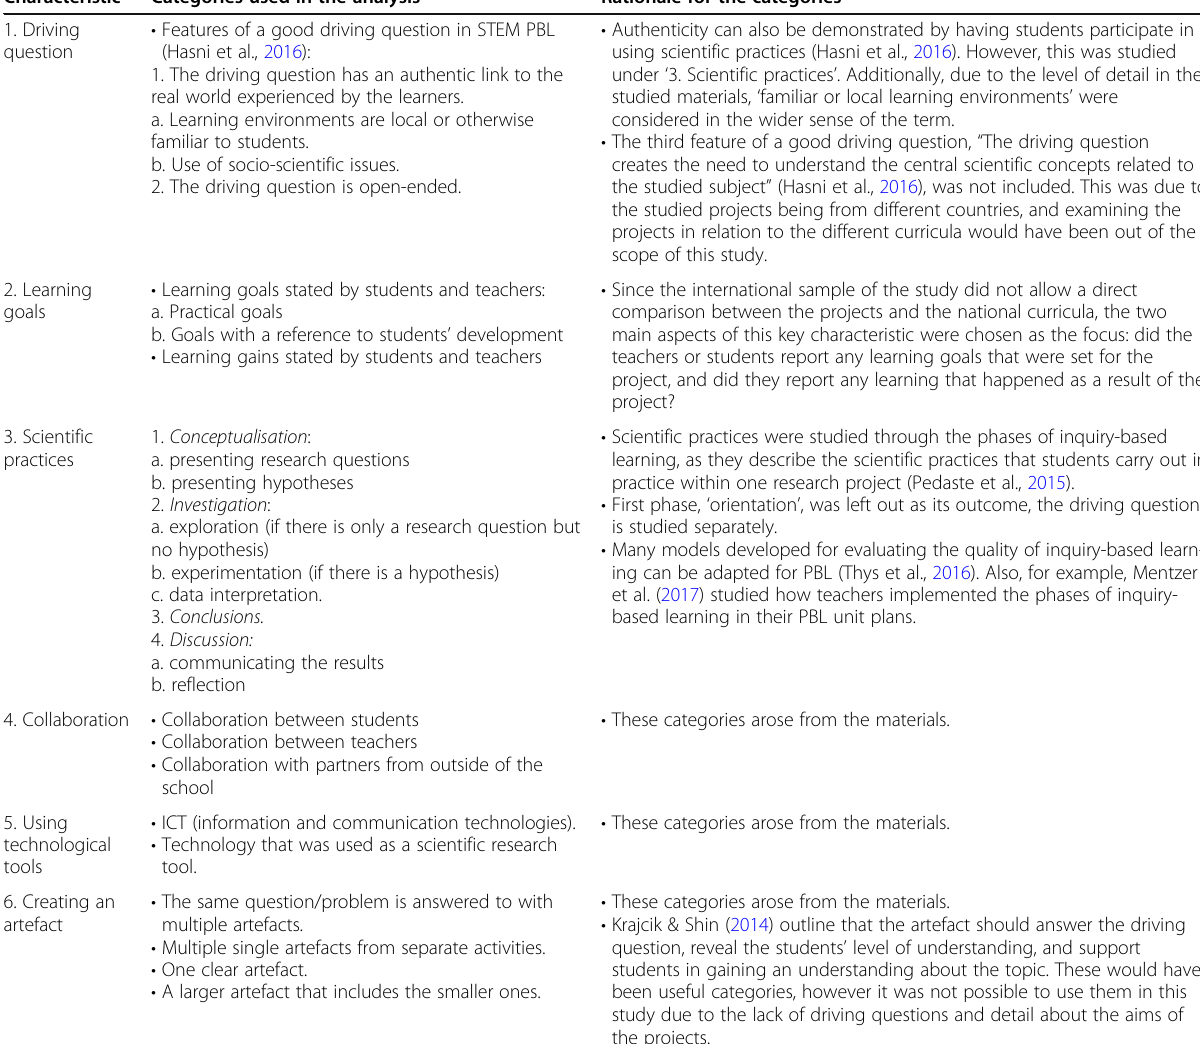
Table 2 The chosen framework for content analysis